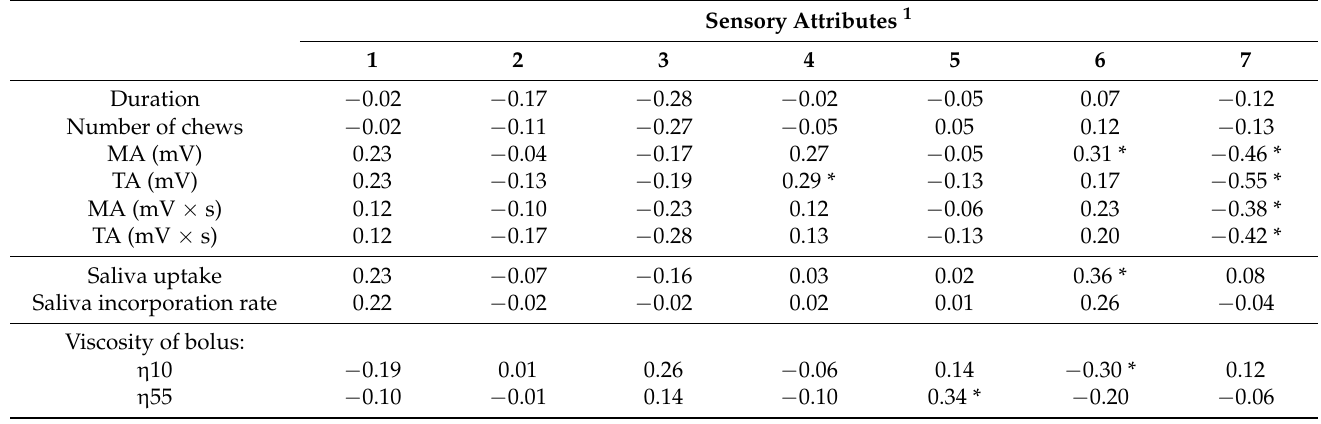
Table 8. Pearson’s correlations between sensory attributes and oral-processing parameters of PGs. Sensory Attributes